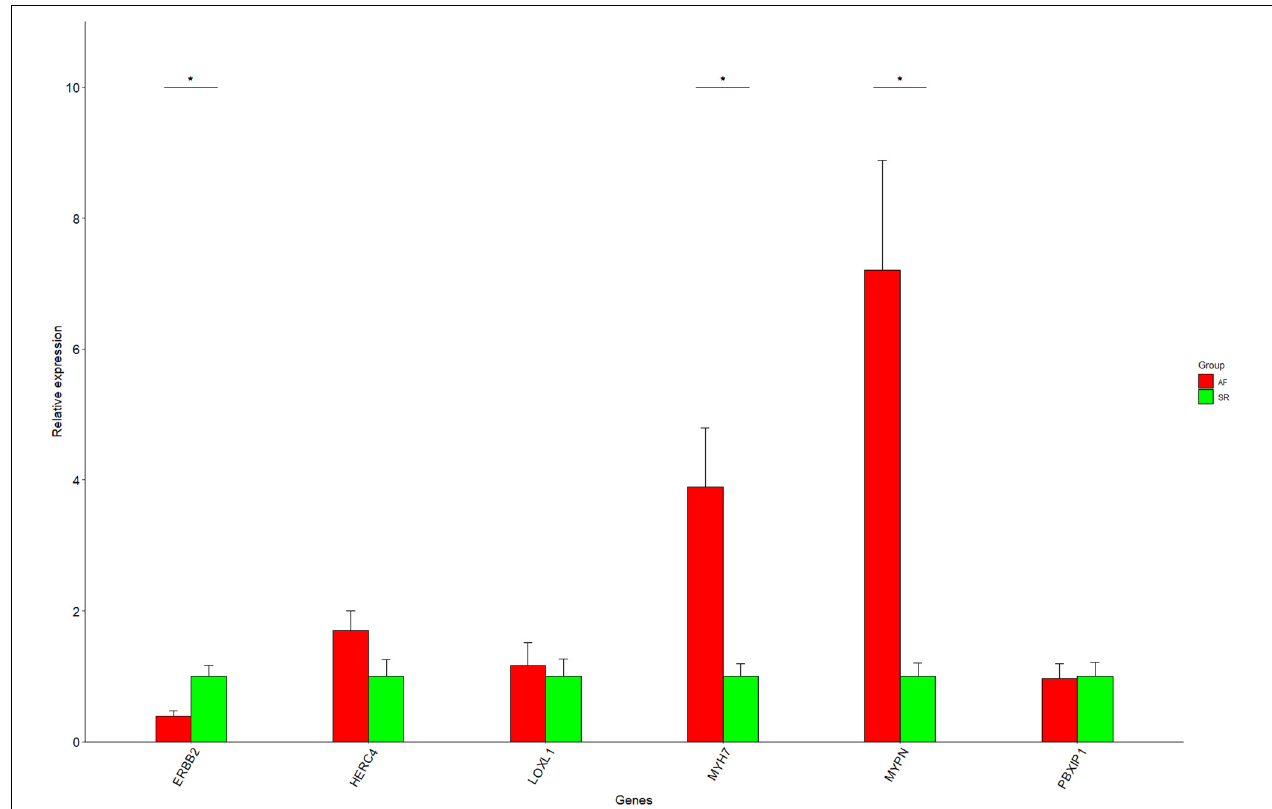
FIGURE 8 | The RT-qPCR results for six genes. Data are shown as mean ± SE, and each sample is in triplicate. AF, atrial fibrillation; SR, sinus rhythm. * P <